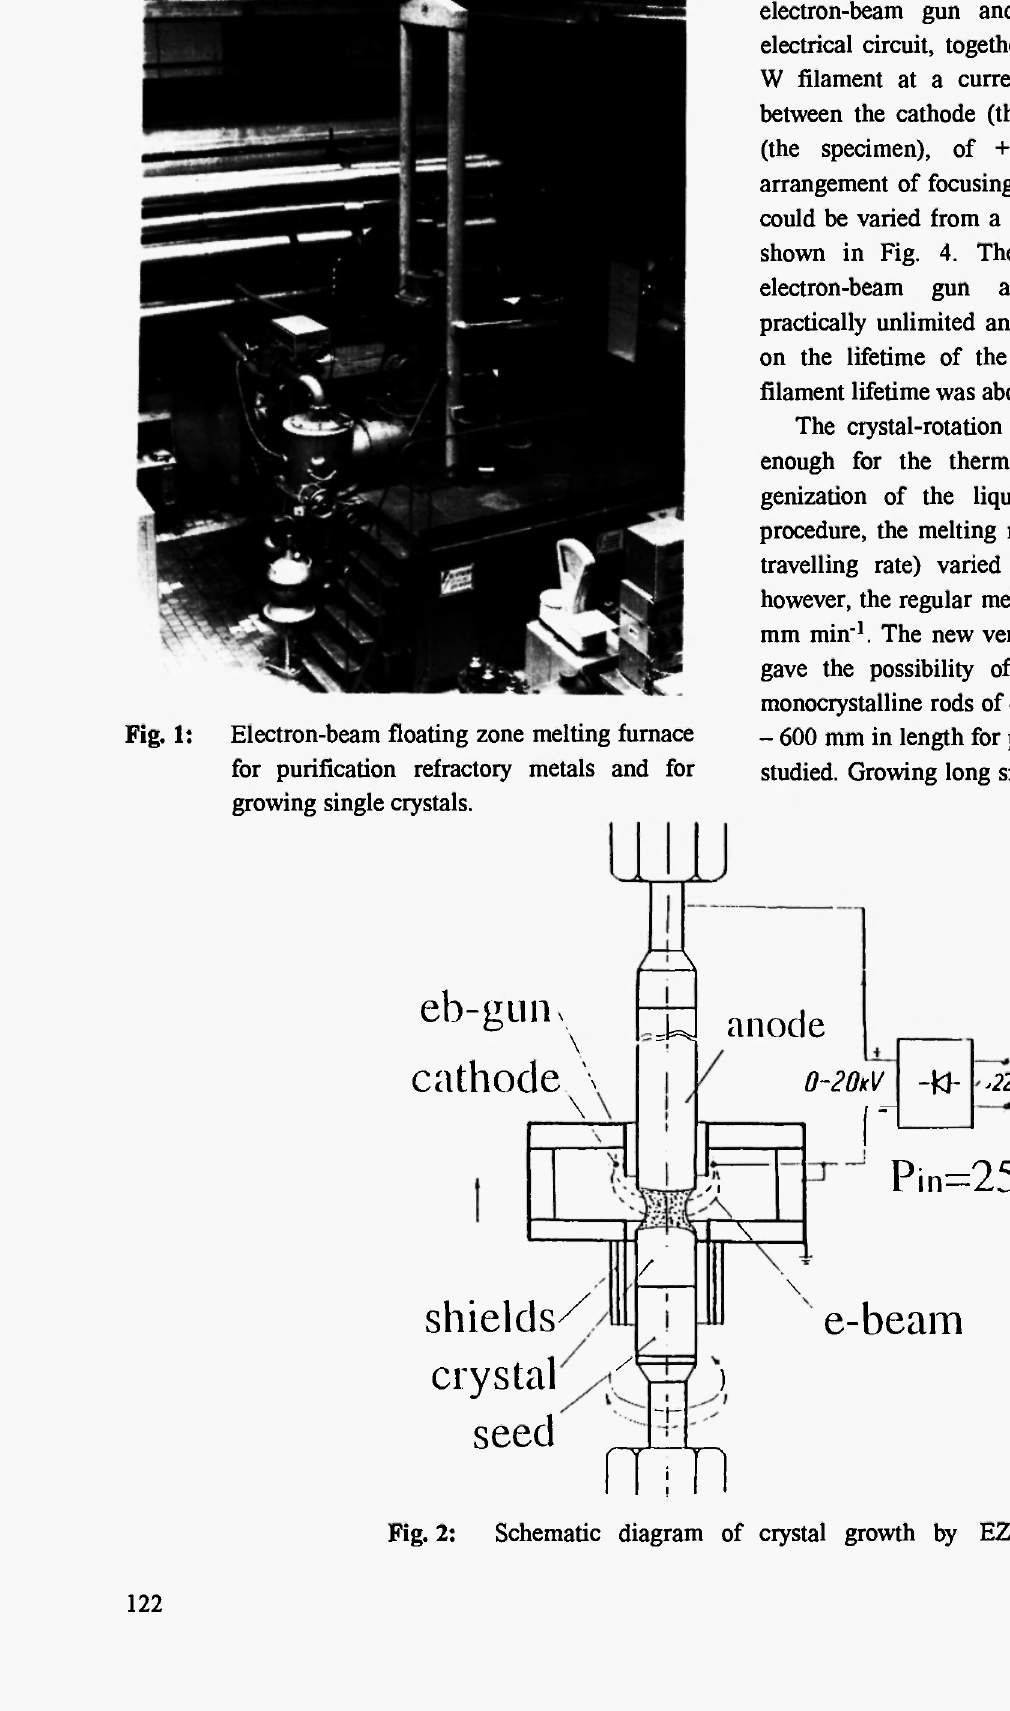
Fig. 1: Electron-beam floating zone melting furnace for purification refractory metals and for growing single crystals.